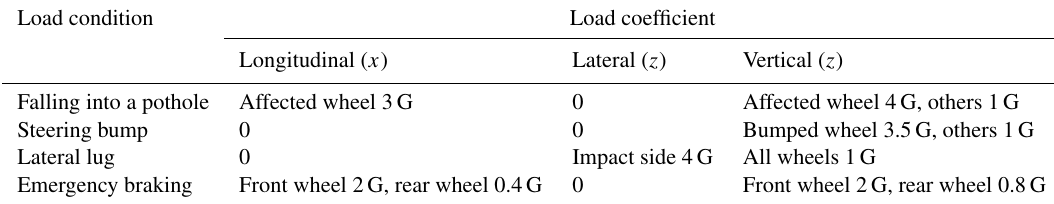
Table 5. Dynamic load coefficients (Happian-Smith, 2008). Front single wheel mass: 126kg, rear single wheel mass: 57kg.